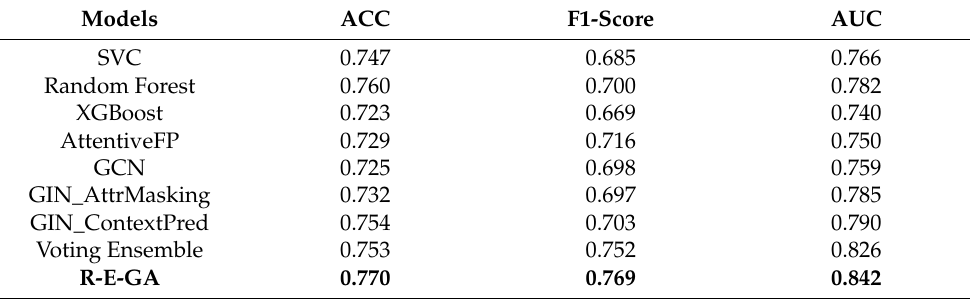
Table 2. Comparison of ACC, F1-score, and AUC